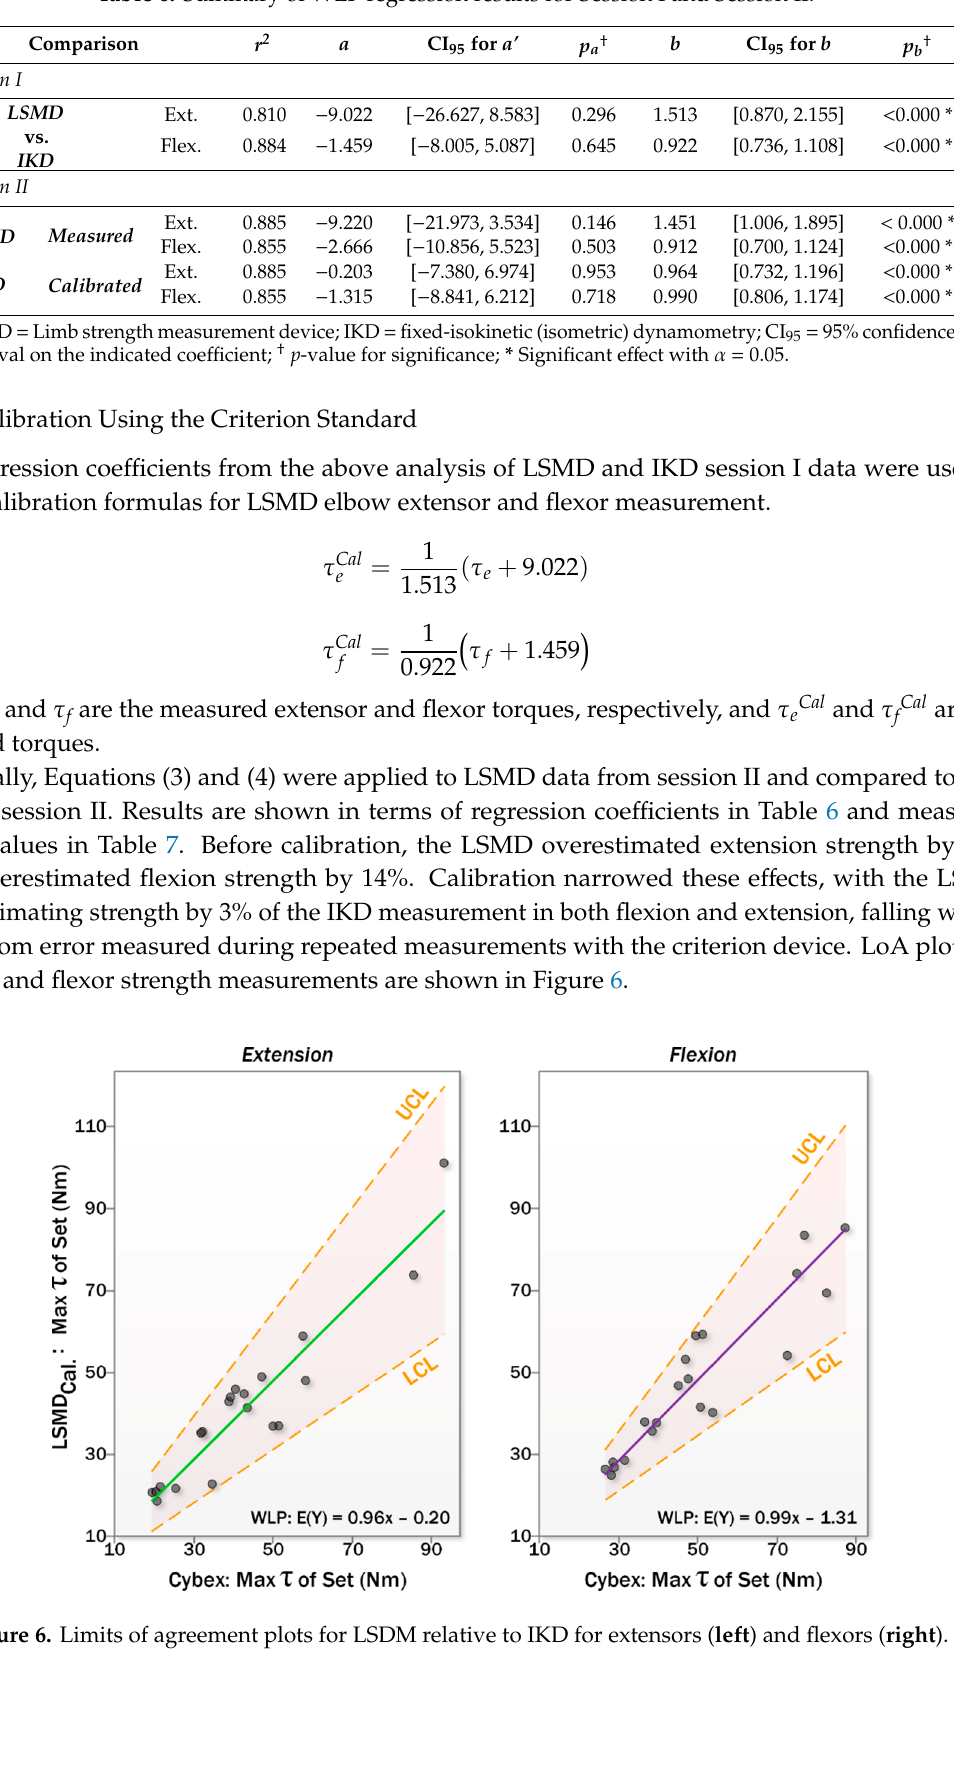
Table 6. Summary of WLP regression results for Session I and Session II.